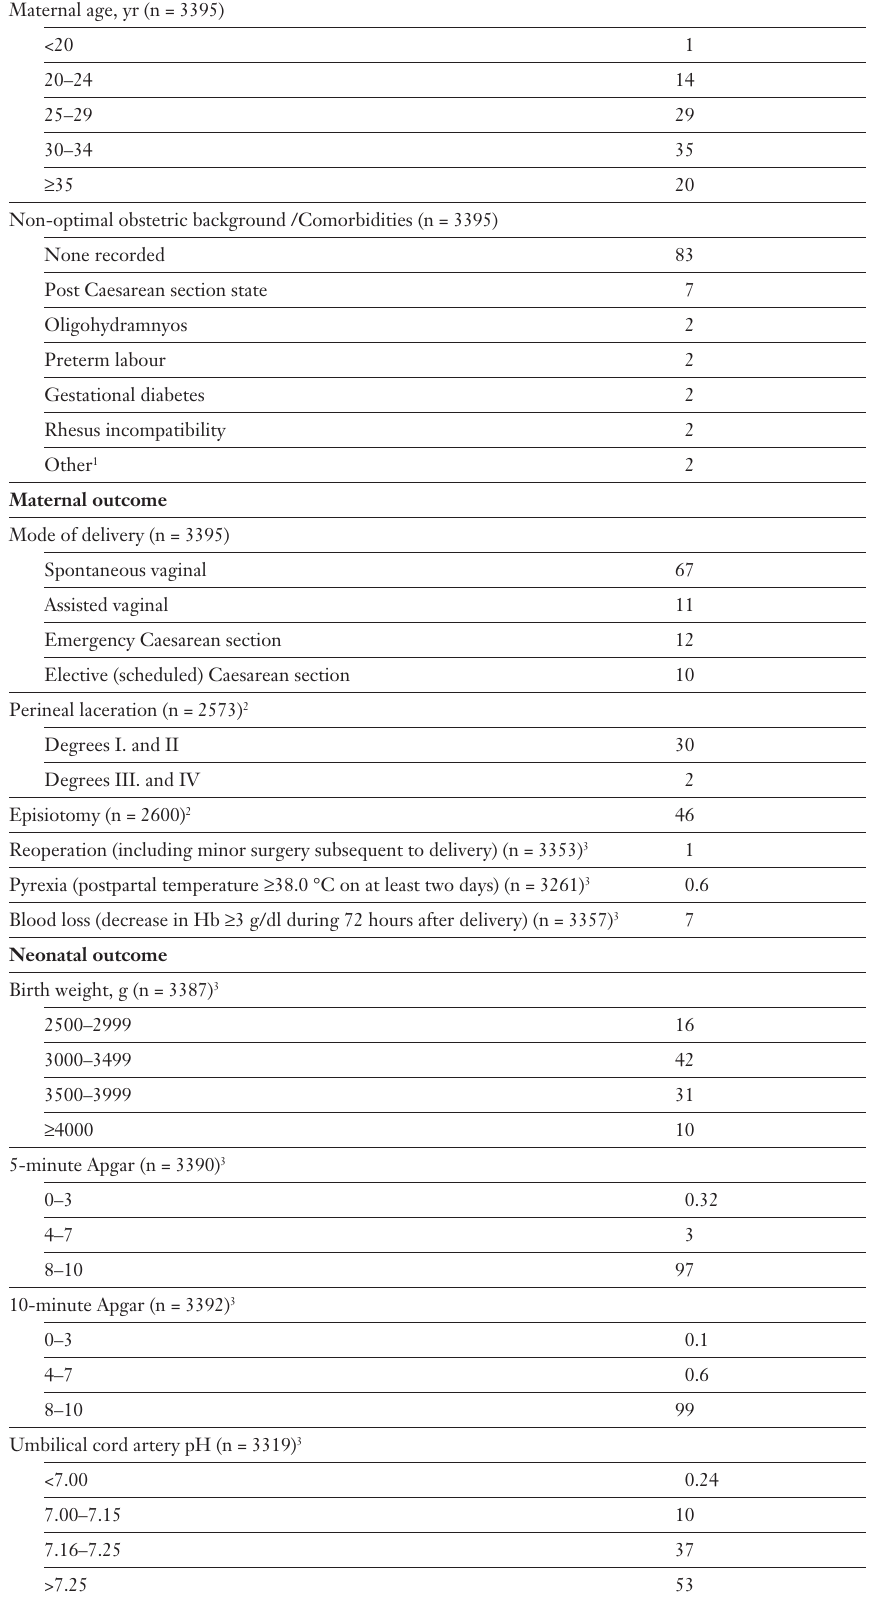
Clinical maternal and neonatal